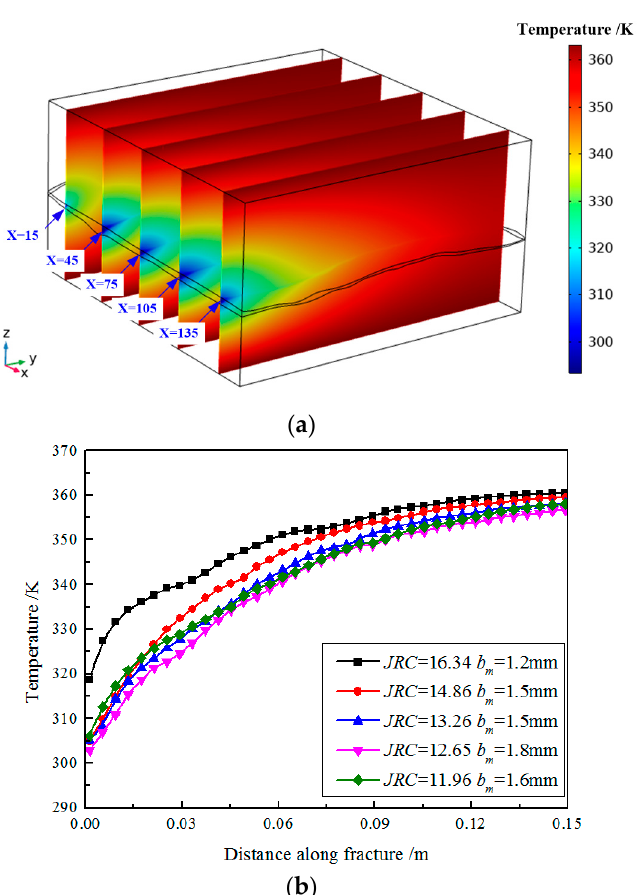
Figure 8. Temperature distribution of 3D fracture for ( a ) spatial temperature variation and ( b ) tem- perature change along fracture profiles.